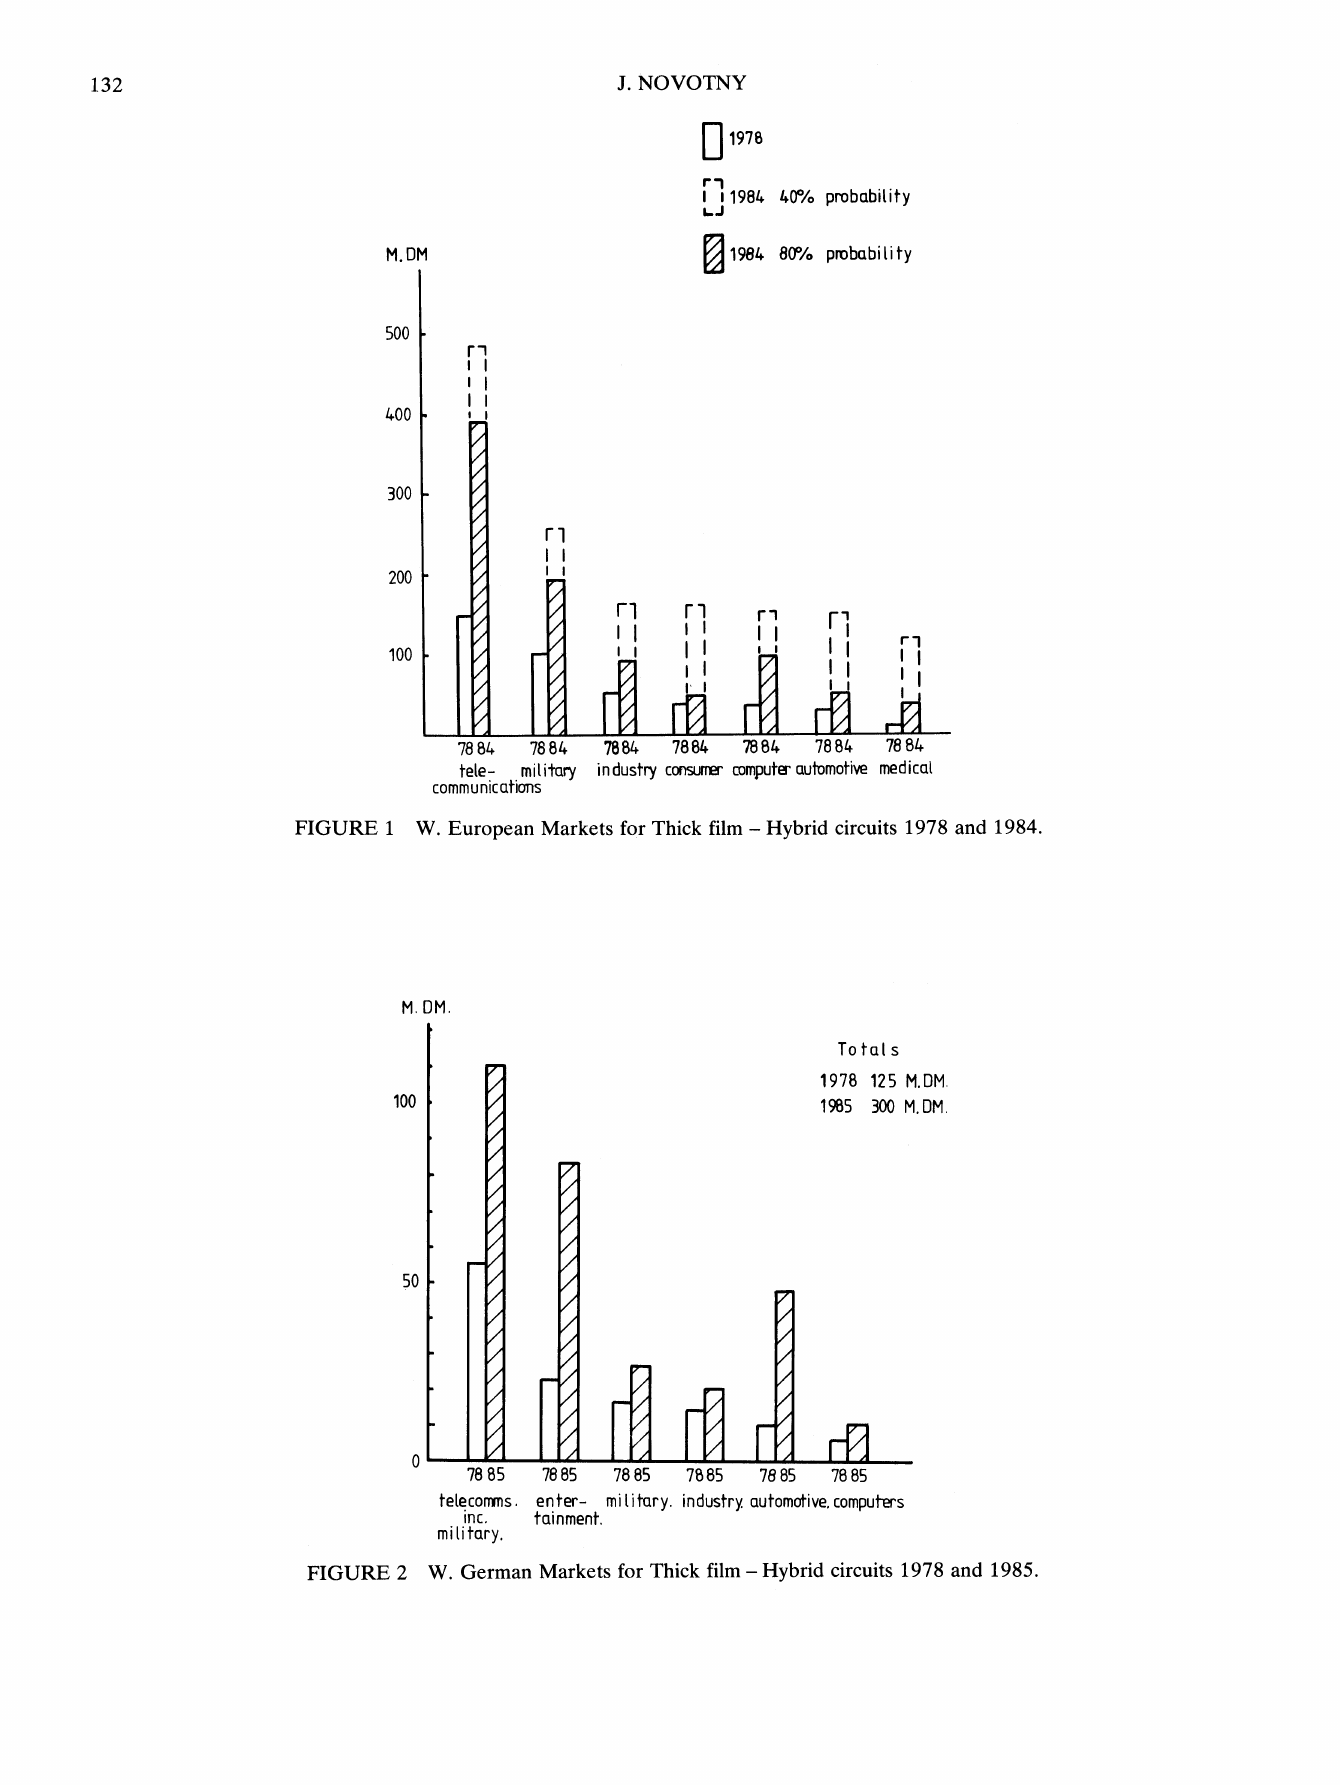
FIGURE 2 W. German Markets for Thick film-Hybrid circuits 1978 and